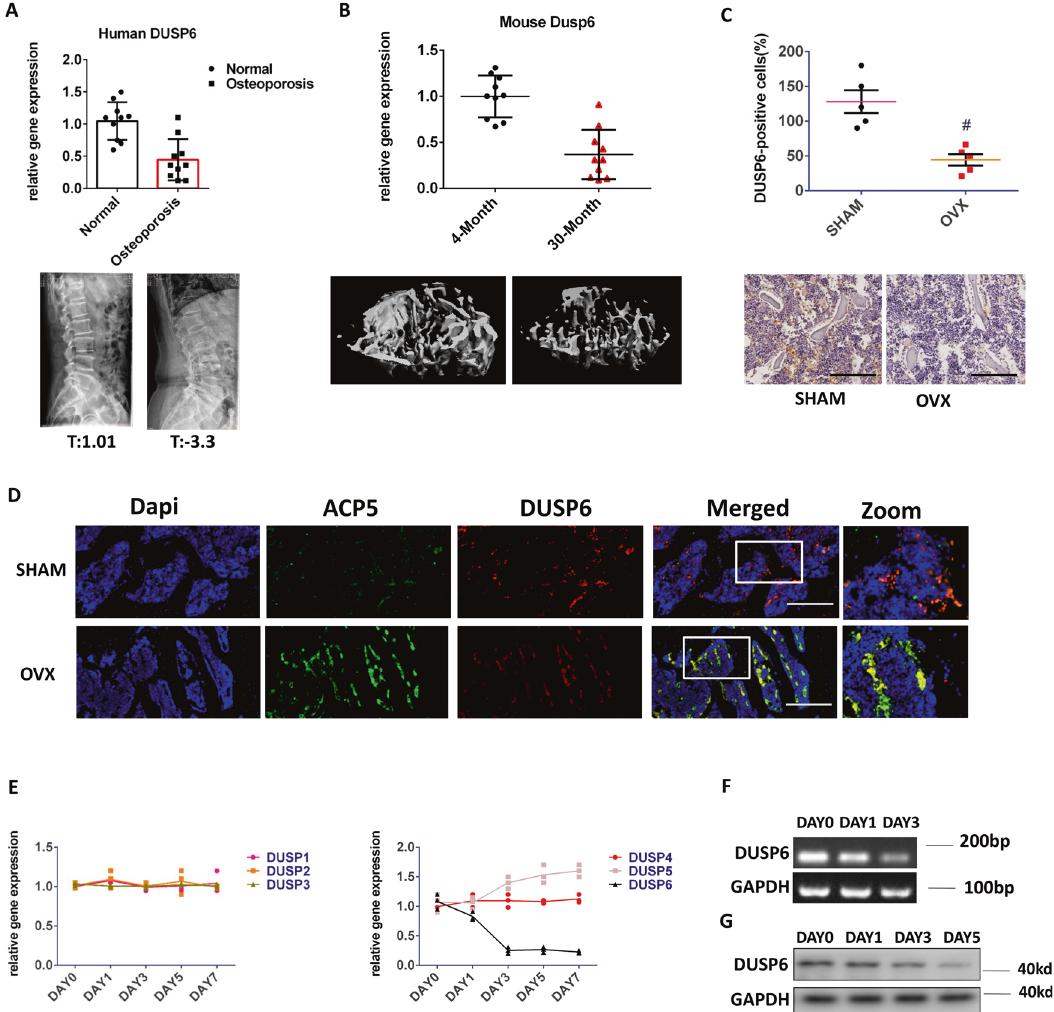
4F). con fi rmed the enhanced expression of ACP5 and CTSK in (E/Z)-BCI-treated group (Fig. 4G,